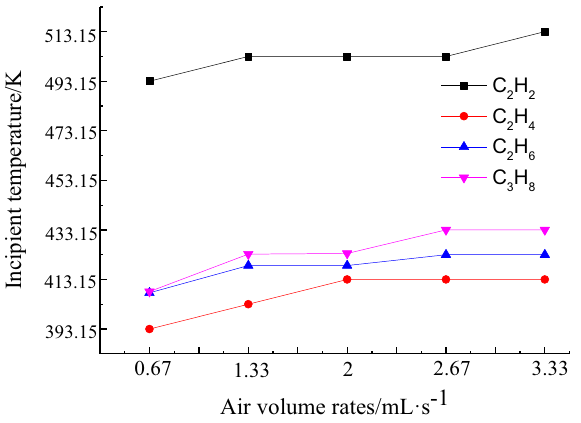
Figure 4. Variation in the first appearance temperatures of C 2 H 6 , C 3 H 8 , C 2 H 4 , and C 2 H 2 under different air volume